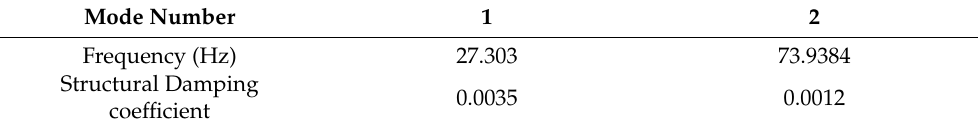
Table 6. Experimental natural frequencies and damping coefficients of the damaged steel beams.